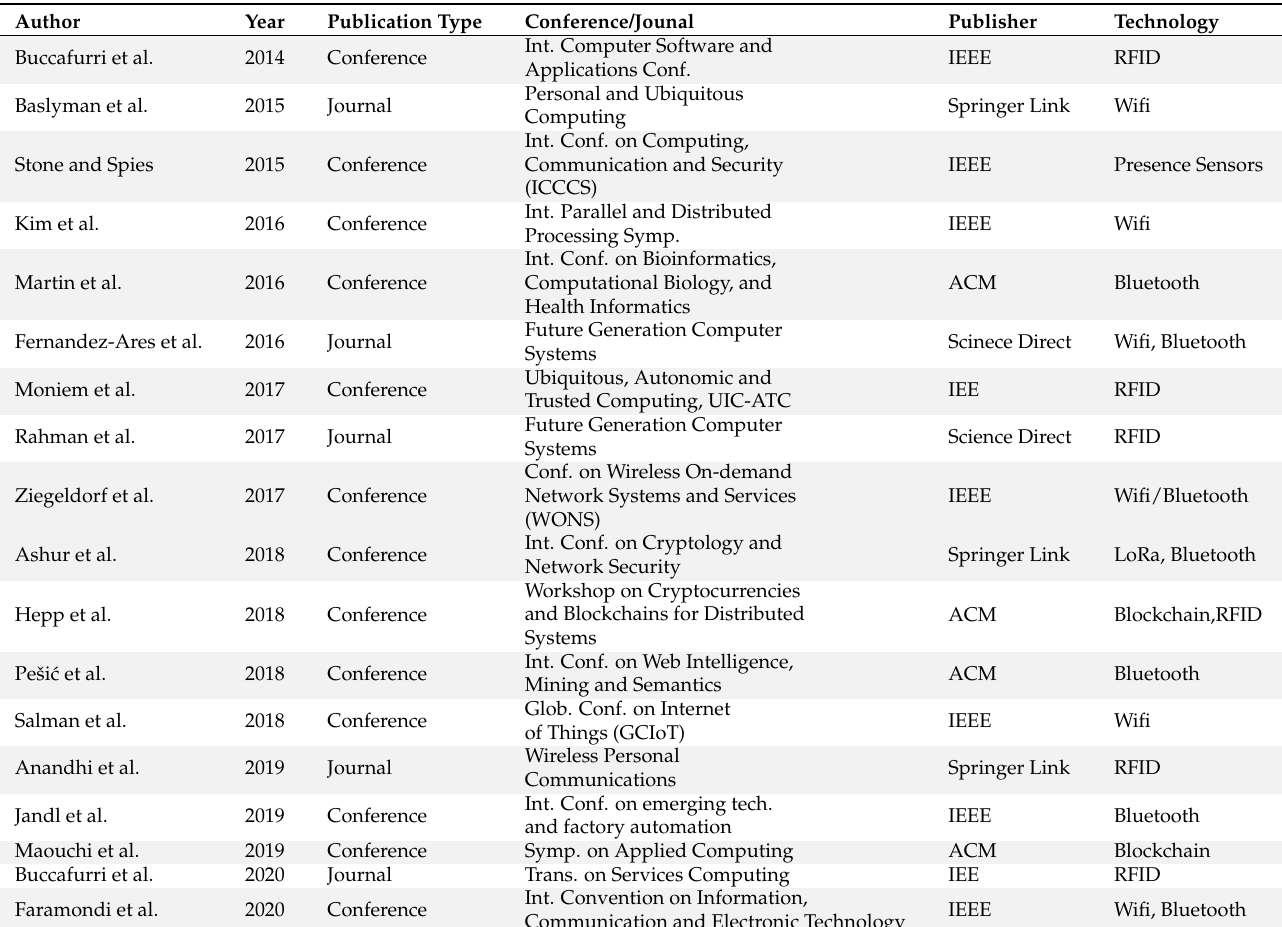
Table 3. Articles which were used for this review.